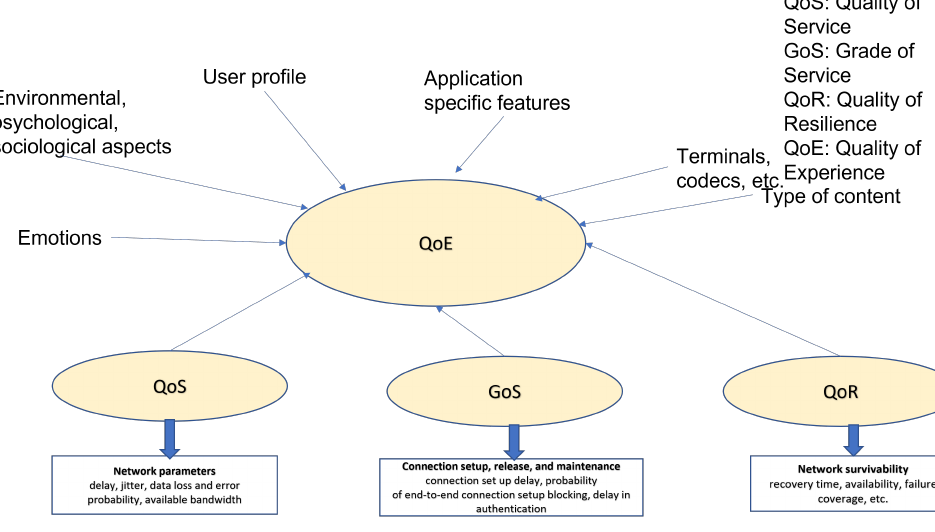
Figure 3. Factors influencing QoE